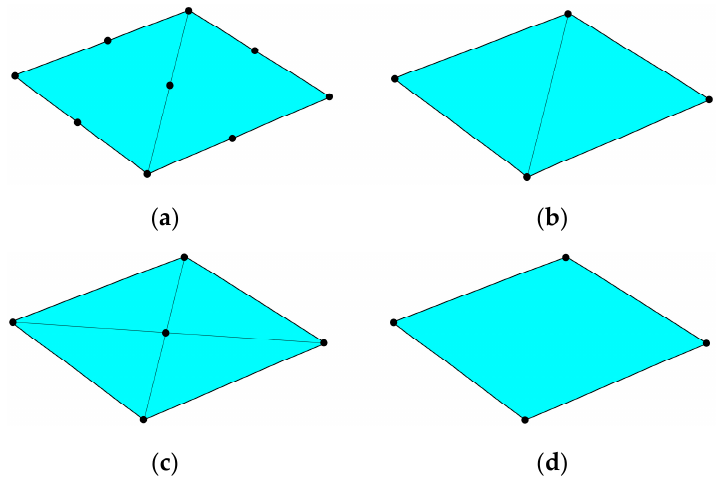
Figure 6. Meshes of finite element models used in the study: ( a ) STRI65, ( b ) S32, ( c ) S34 and ( d ) S4 / S4R.